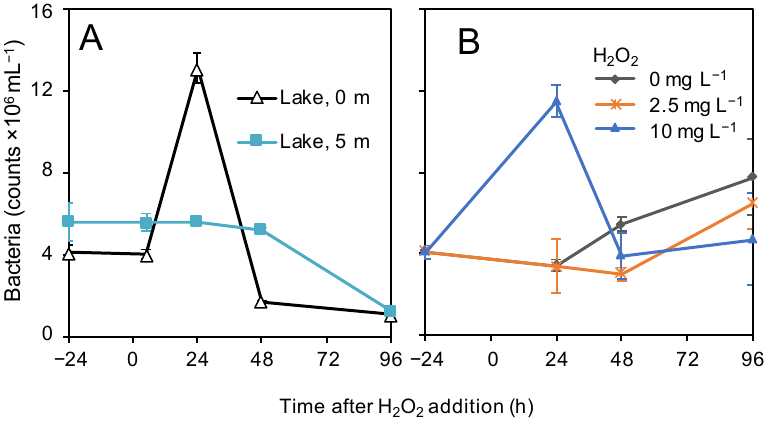
Figure 4. Total bacterial abundances during the H 2 O 2 treatment in August. Total bacterial abun- dances as determined with flow cytometry during ( A ) the lake treatment and ( B ) the incubation experiments in August. The data show the mean ( ± SD) based on n = seven biological replicates for t = − 24 h at 0 m ( A ), n = six biological replicates for t = − 24 h at 5 m ( B ) and n = four biological replicates for all the other time